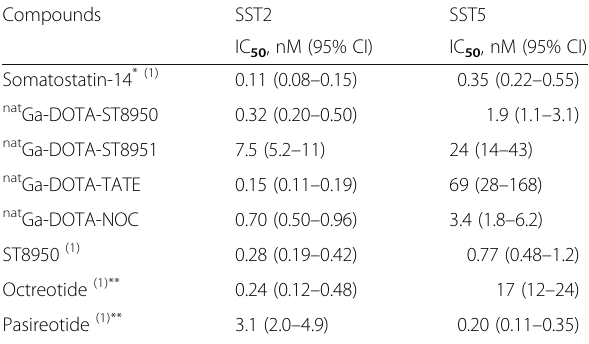
Table 2 Affinity toward SST2 and SST5 of all four nat Ga-DOTA- conjugates compared to reference somatostatin analogs Compounds